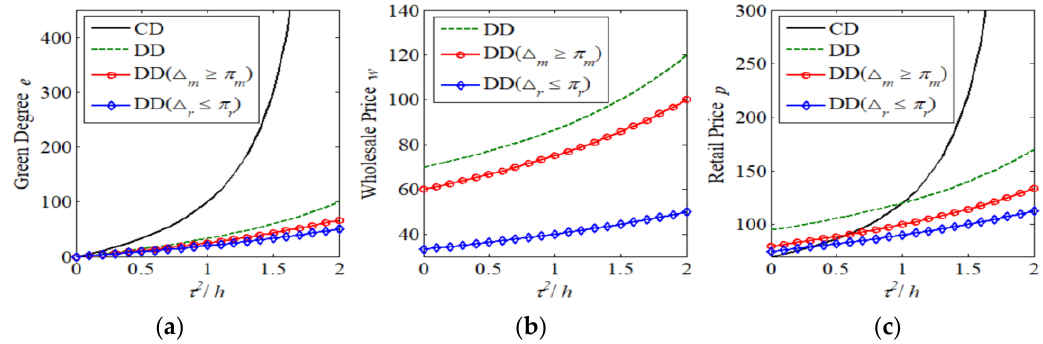
Figure 1. The effects of green efficiency coefficient of products (GECP) on decision variables.